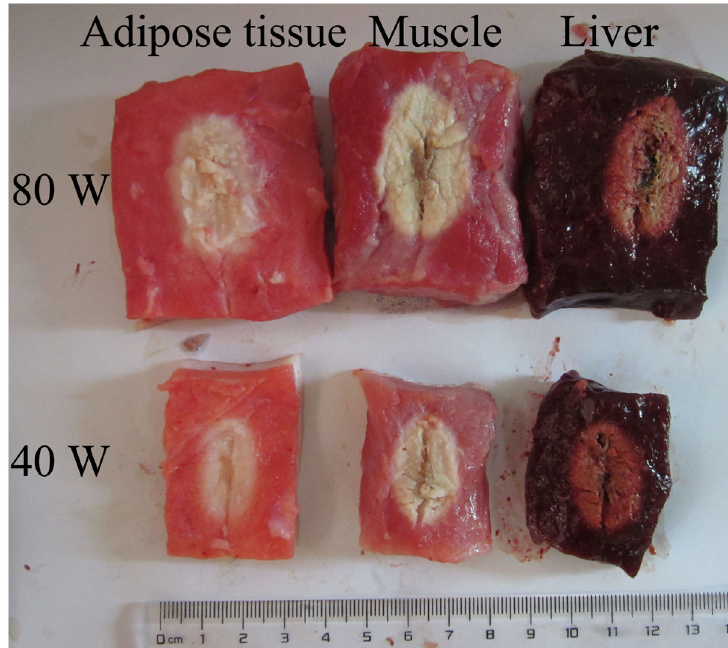
Figure 3. The coagulation zone (white zone) in adipose tissue, muscle and liver after 2,3,5-triphenyl tetrazolium chloride stain at two power output settings (40 W and 80 W) for 3 minutes of time